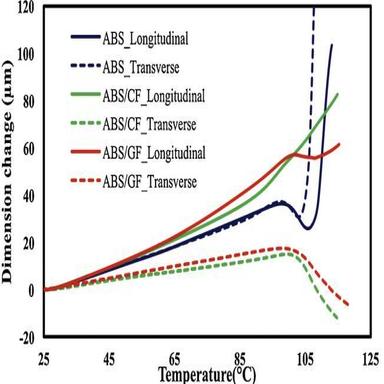
Representative TMA curve of single specimen experiment of neat and short fiber-reinforced ABS composites.